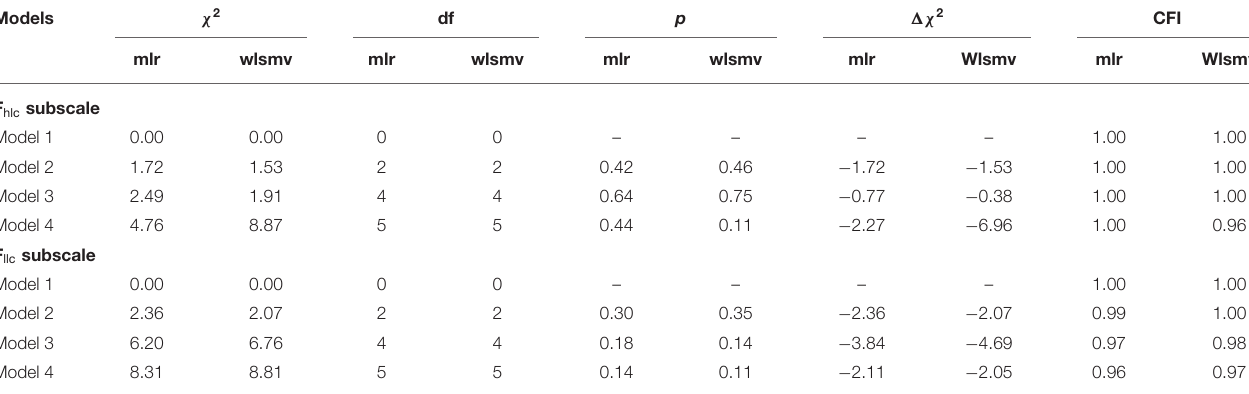
TABLE 7 | Scaled chi-square difference test of F hlc and F llc subscales (method = “satorra.bentler.2001”).